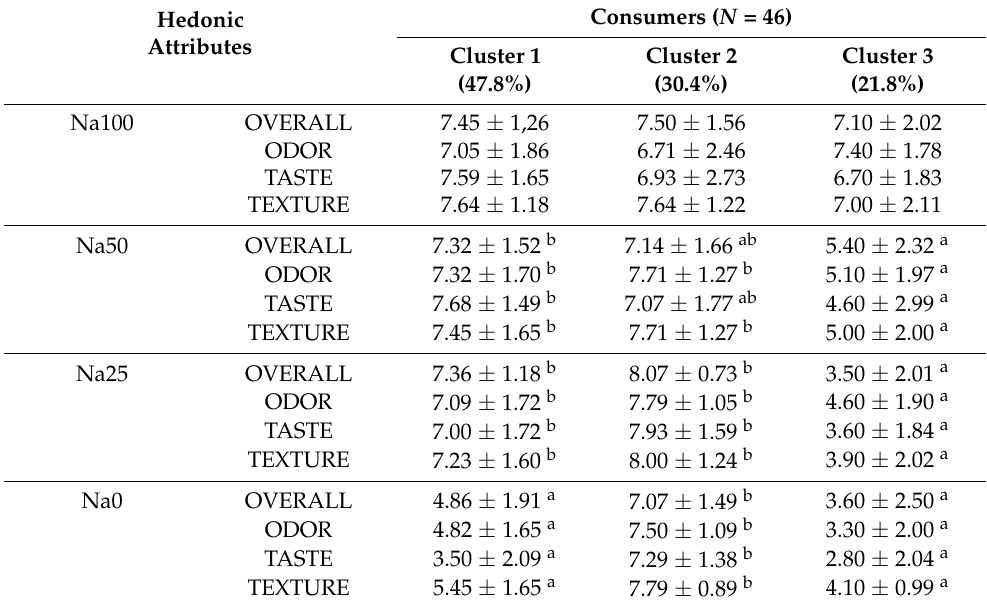
Table 6. Consumer scores for white brined cheeses salted with different ratios of NaCl and